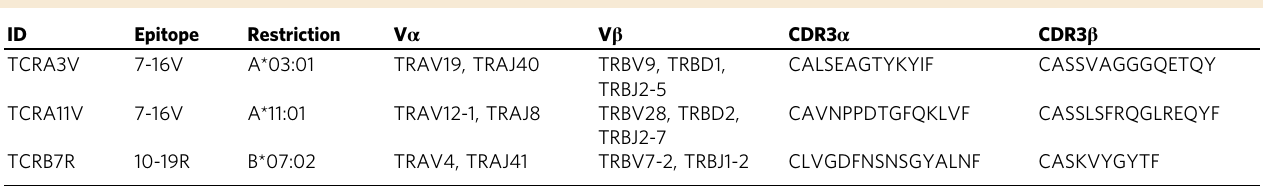
Fig. 2 Assessment of mKRAS neoantigen immunogenicity and identi fi cation of mKRAS-speci fi c TCR sequences. a IFN- γ ELISPOT assay results following in vitro expansion of healthy donor puri fi ed CD8 + T cells stimulated with mKRAS peptide-pulsed autologous mDC. IFN- γ ELISPOT Spot Forming Cell (SFC) values are substrated from media controls for each subject. The data presented are the pooled results from single experiments of individual donors represented by symbols indicated in the fi gure legend. Red symbols denote donors with positive responses. b p-HLA multimer analysis demonstrating positive 7-16V-speci fi c HLA-A*03:01-restricted CD8 + T cell response isolated from donor D429. c p-HLA multimer analysis demonstrating positive 7-16V-speci fi c HLA-A*11:01-restricted CD8 + T cell response isolated from donor D500. d p-HLA multimer analysis demonstrating positive 10-19R- speci fi c HLA-B*07:02-restricted CD8 + T cell response isolated from donor D516. Cells were stained with p-HLA multimer and anti-CD8 Ab. p-HLA multimer staining of respective donor CD8 + T cells stimulated in the absence of peptide (non-speci fi c) were used as staining controls. A total of 1 × 10 6 live events were collected gating on FSC/SSC/CD8 + cells. Data presented in panels ( b – d ) are representative of two independent tests. Source data are provided as a Source Data fi le. Table 1 Summary table of